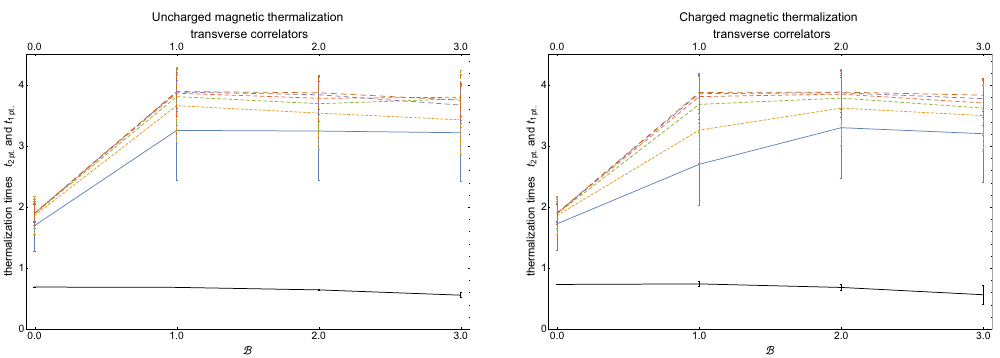
Figure 25 . Thermalization times as a function of the magnetic (cid:12)eld. Shown here are the trans- verse 2-point function thermalization times t 2 pt: in a thermalizing (cid:13)uid calculated with the al- ternative measure (4.2). The dashed lines from bottom to top correspond to length separations l = 0 : 5 ; 0 : 7 ; 0 : 9 ; 1 : 1 ; 1 : 3 ; 1 : 5. Error bars indicate an estimate of Left: uncharged (cid:13)uid, (cid:26) = 0, B = 0 ; 1 ; 2 ; 3. Right: charged (cid:13)uid, (cid:26) = 0 : 78 (cid:26) e , B = 0 ; 1 ; 2 ; 3. Data points have been joined by straight lines to guide the